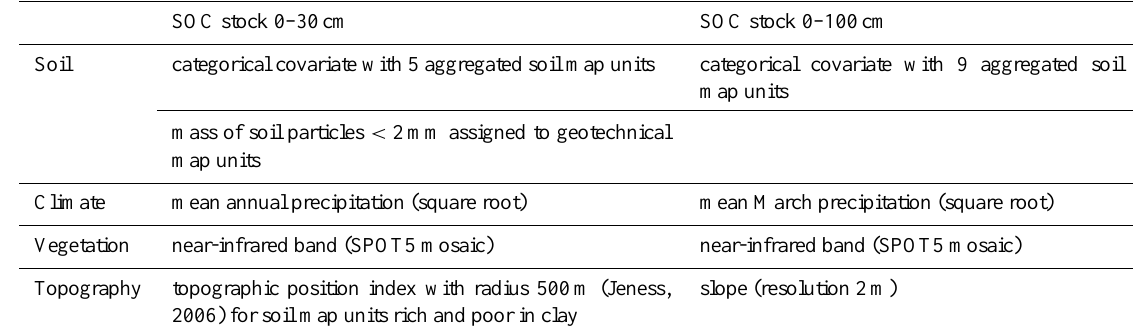
Table 1. Covariates of external drift selected by model building procedure for soil organic carbon (SOC) stocks in 0–30cm and 0–100cm